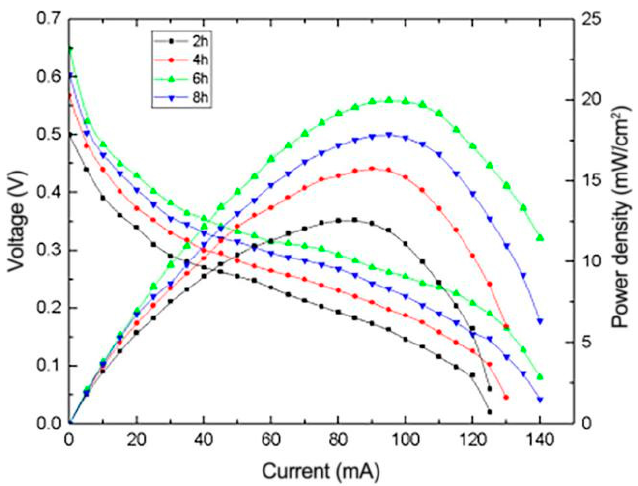
Figure 5. Effect of heating time on the performance of μ DMFC.